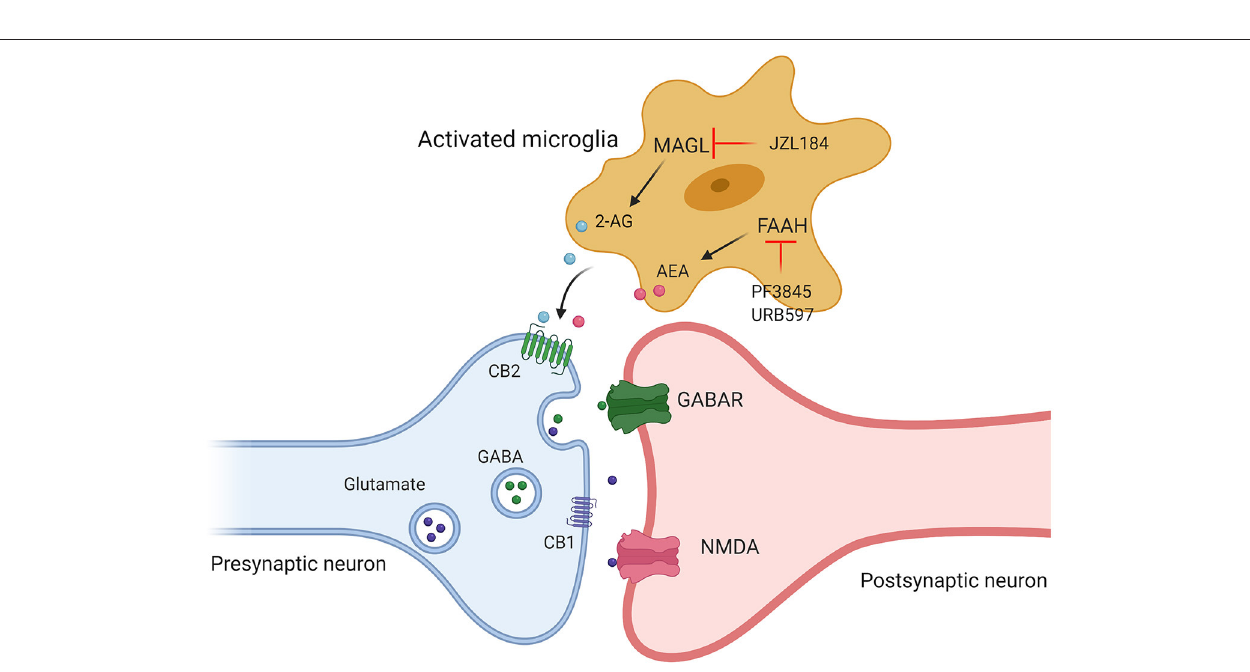
FIGURE 3 | Targeting different components of ECS (2-AG, AEA, CB1, and CB2) may provide therapeutic strategies for the treatment of ASD. Administration of JZL184, a pharmacological inhibitor of MAGL, enhanced 2-AG signaling, by using FAAH inhibitor (PF3845, URB597) to increase AEA levels to promote the release of excitatory and inhibitory amino acid transmitters by acting on cannabinoid